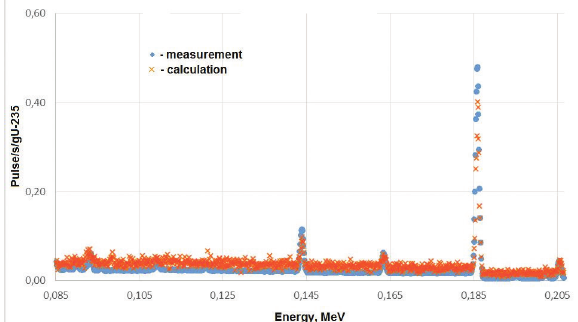
Figure 4. Comparison of the measured and calculated gamma quanta spectra from cellulose-containing cask. The waste mate- rial density is 0.708 g/cm 3